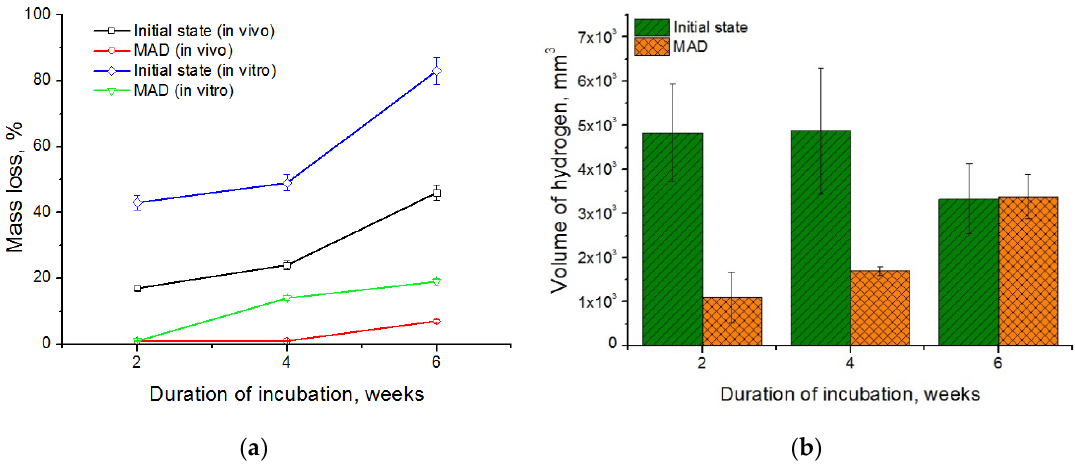
Figure 5. A comparison of the in vitro and in vivo biodegradation rate ( a ), as well as the rate of hydrogen evolution during the incubation in vivo ( b ) of WE43 in the initial and the deformed states.